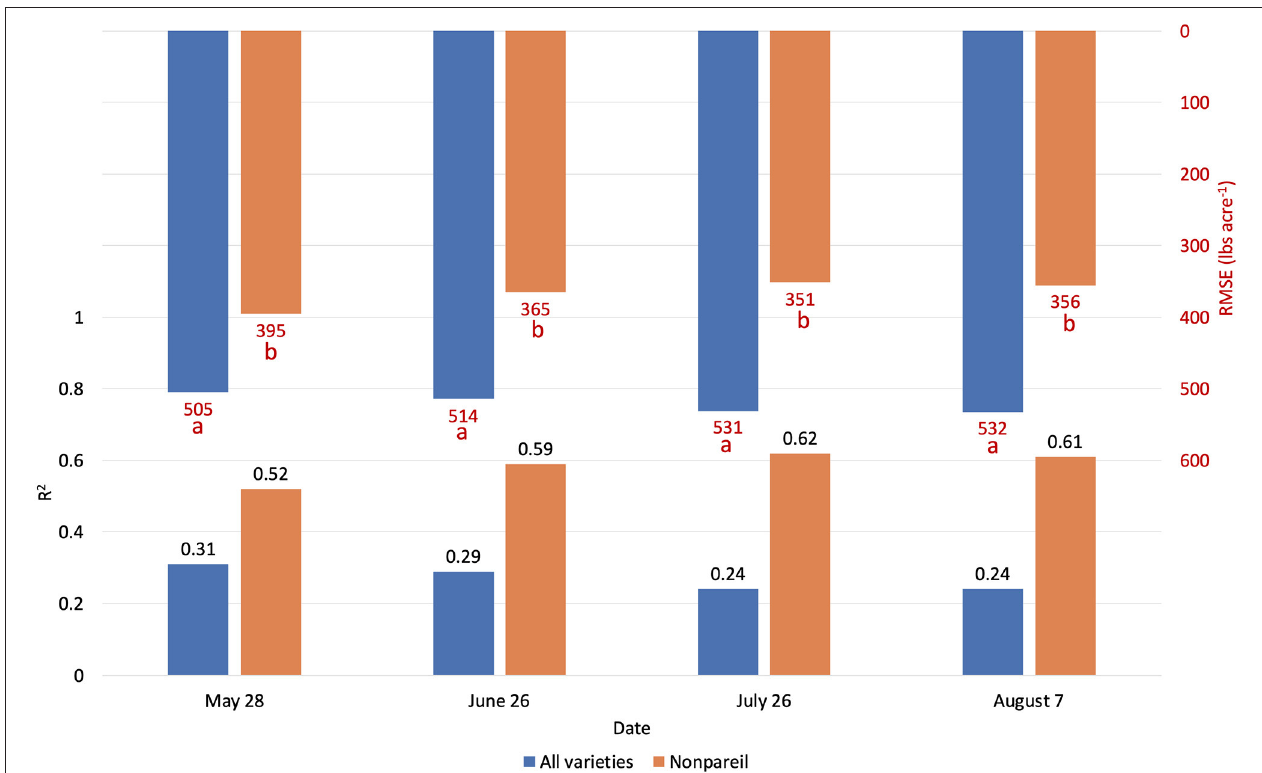
FIGURE 9 | Comparison of R 2 and root mean square error (RMSE) (to regression line) between fPAR Virtual Orchard (fractional PAR estimated by VO) and actual almond kernel yield for all varieties and ‘Nonpareil’ only over the season in 2019 at the per-tree level. Different letters refer to a statistically significant difference testing the means of absolute errors in predicting actual almond yield with different regression models using analysis of variance (ANOVA) multi-comparison ( p <